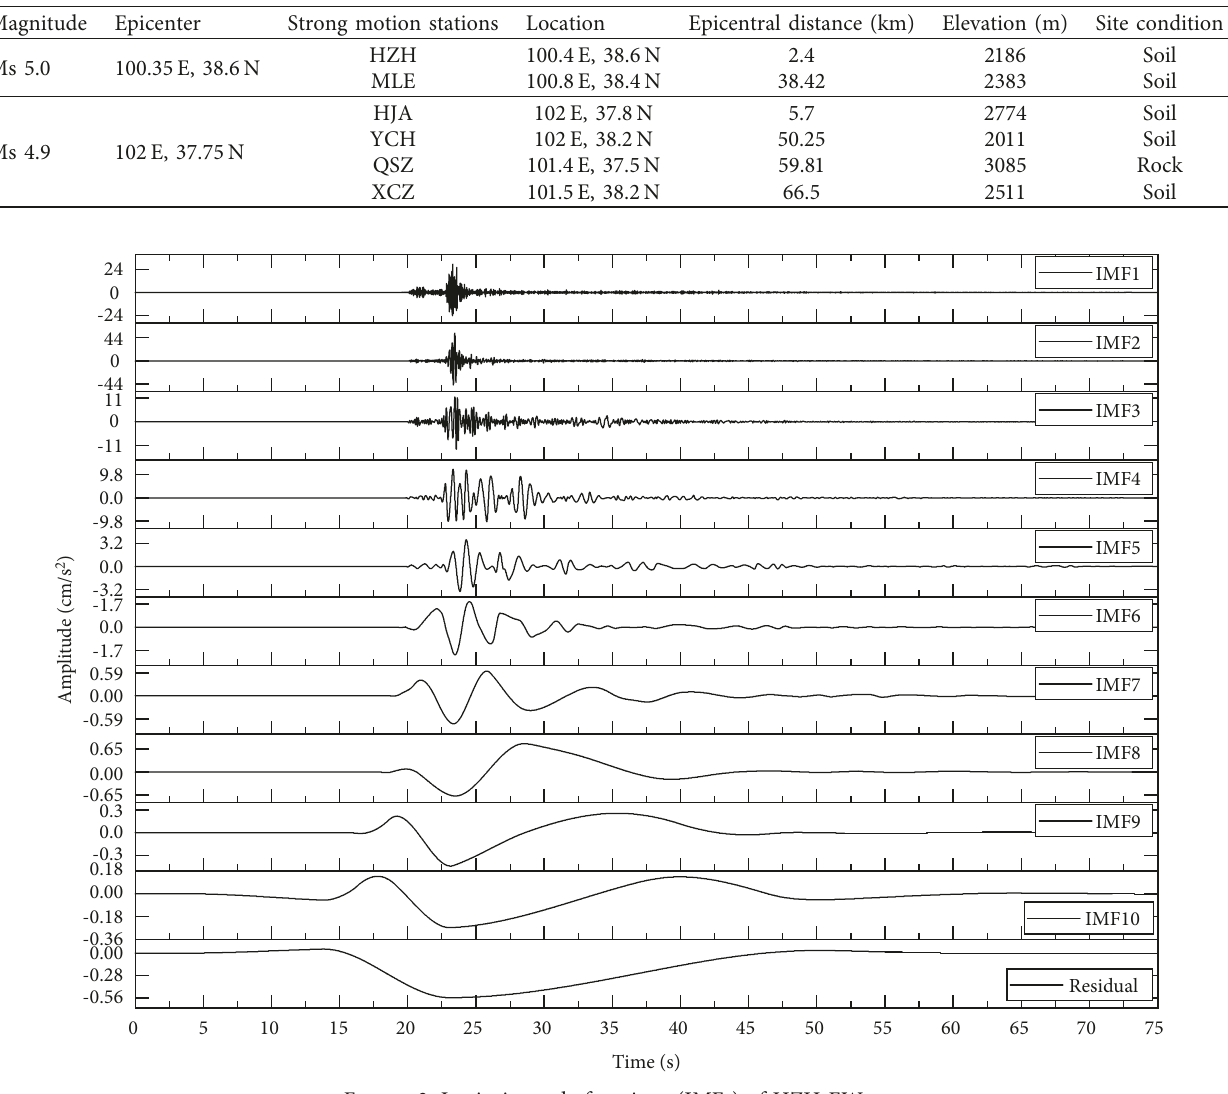
Figure 2: Intrinsic mode functions (IMFs) of HZH-EW.